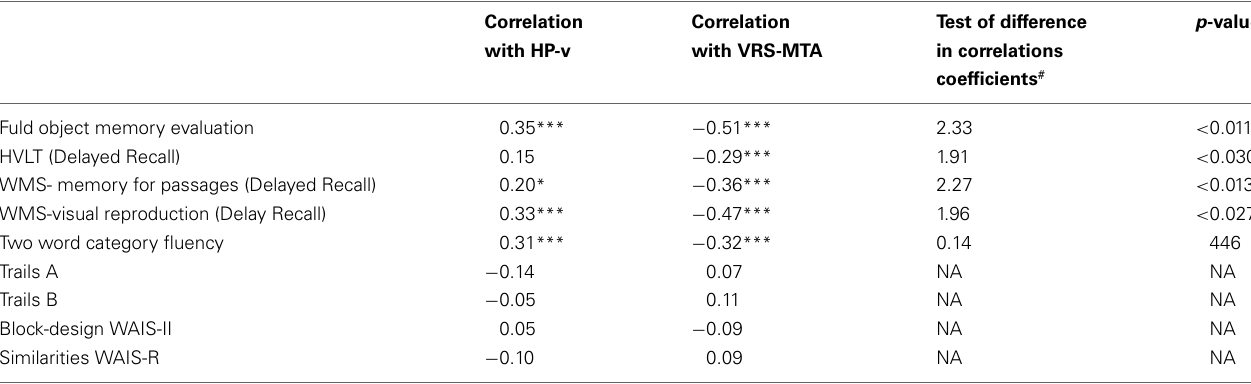
Table 3 | Comparative correlations between volumetric and VRS-MTA measures among 129 cognitively impaired patients.